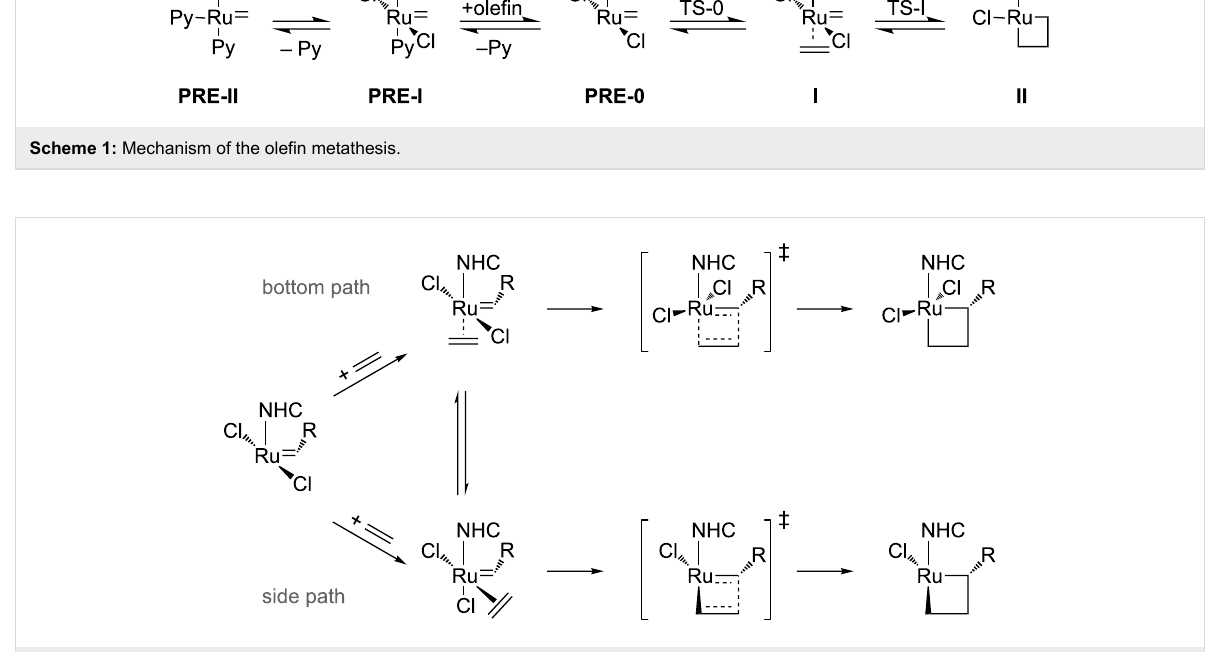
Scheme 2: Possible side or bottom mechanism of the insertion of the olefin.